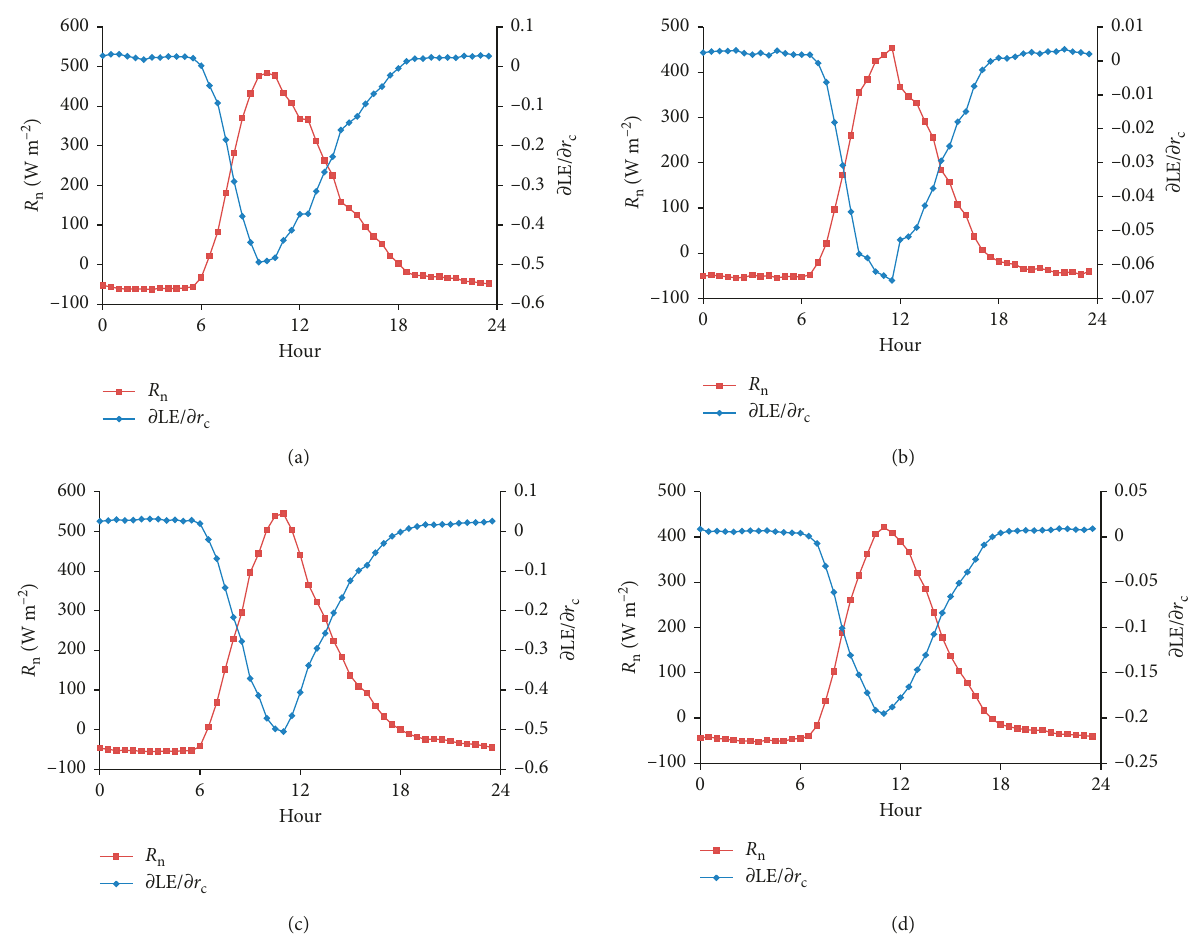
Figure 9: Diurnal variations of z LE / z r c and Rn for the season of (a) warm 2005, (b) cool 2005, (c) warm 2006, and (d) cool